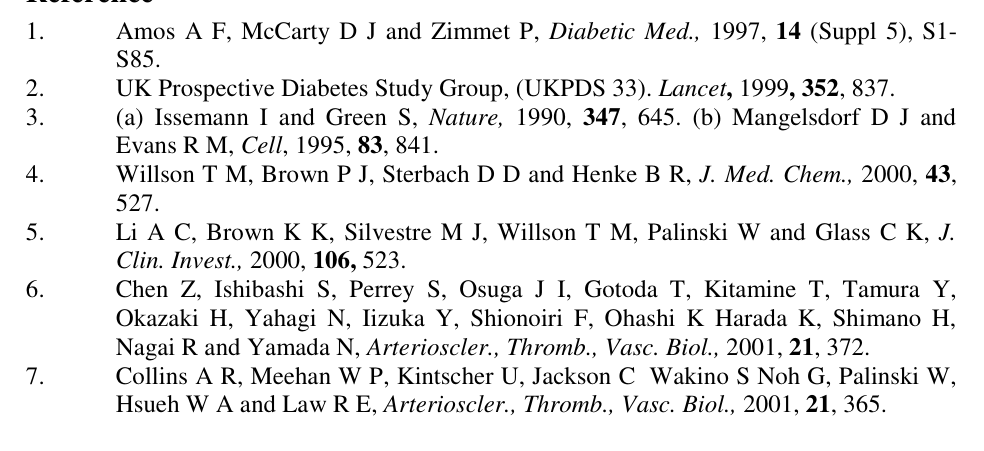
using eqn 3 for PPAR- i